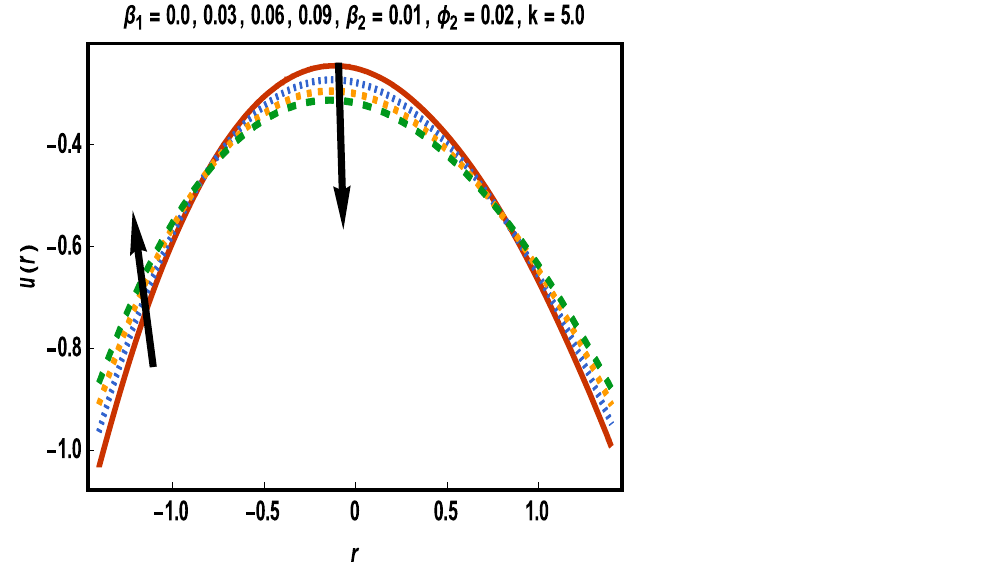
Figure 5. Results of case study 1: scenario 2 ( β 1